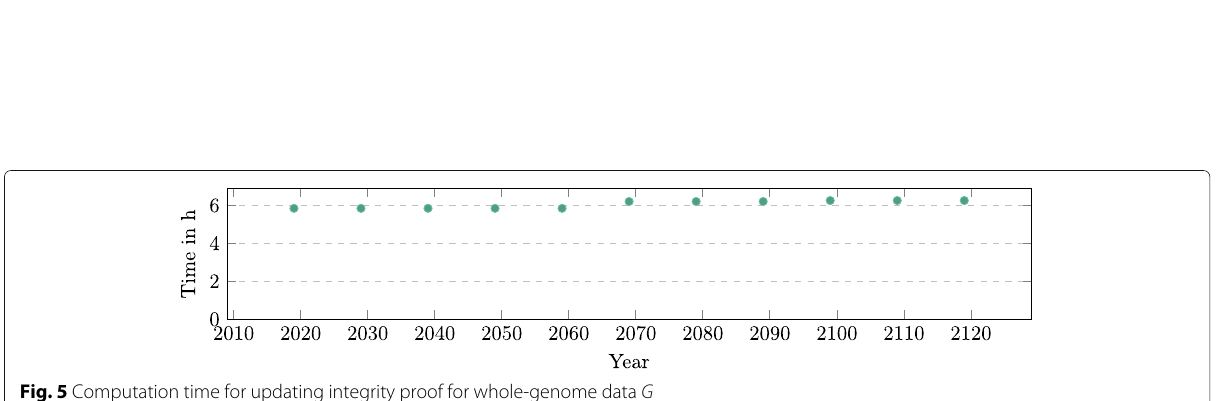
Fig. 5 Computation time for updating integrity proof for whole-genome data G